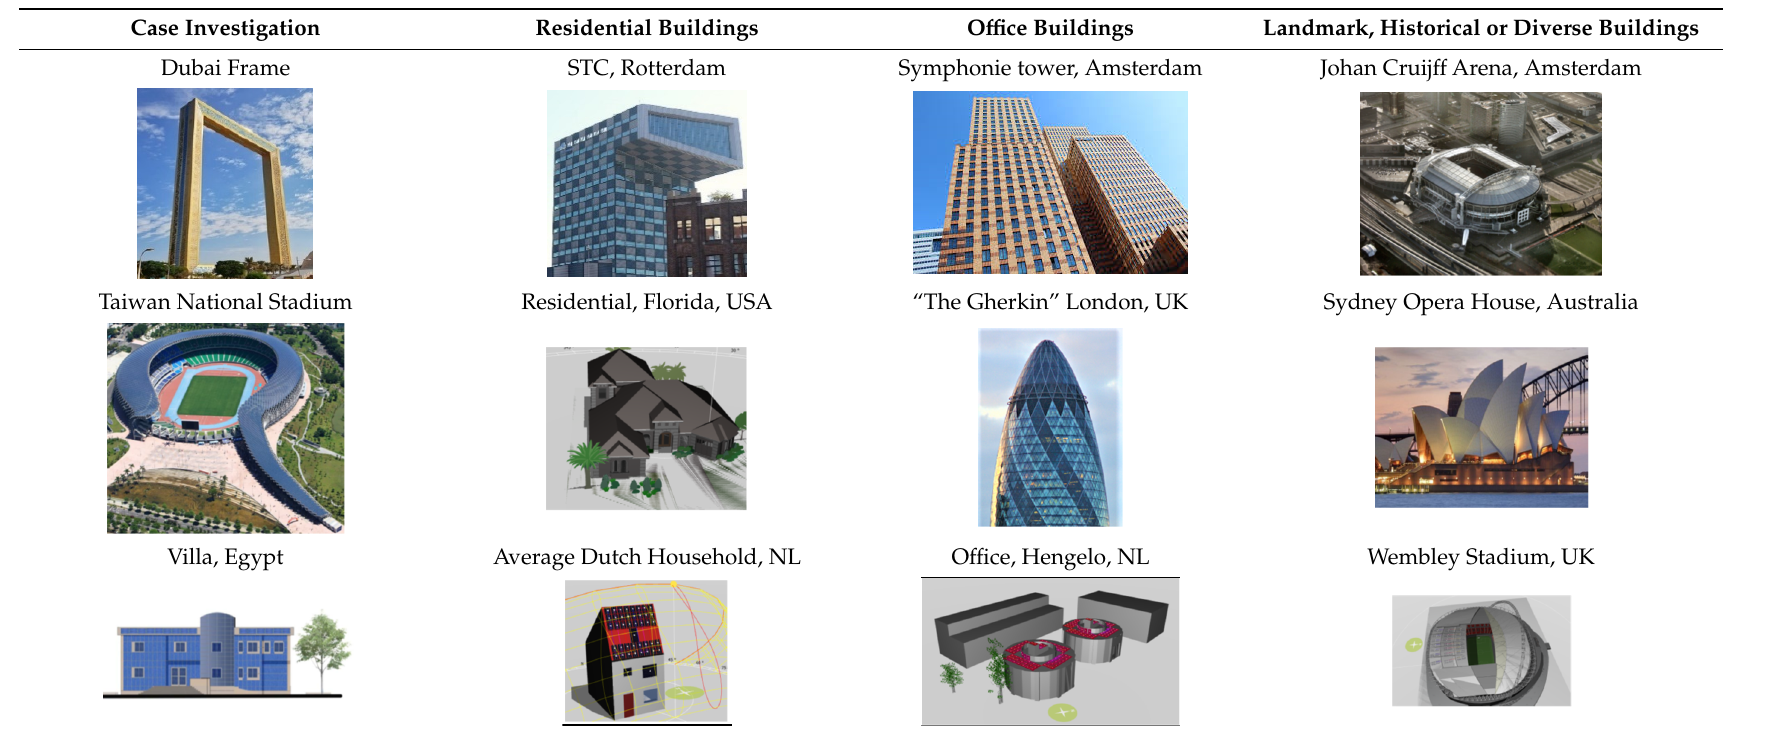
Figure 1. Summary of the modelling steps, data analysis, and evaluation of the projects. 2.1. Selected BIPV Projects for Evaluation Twenty-four BIPV projects were selected (see Table 1) for evaluation by the project teams according to the following criteria: 1.